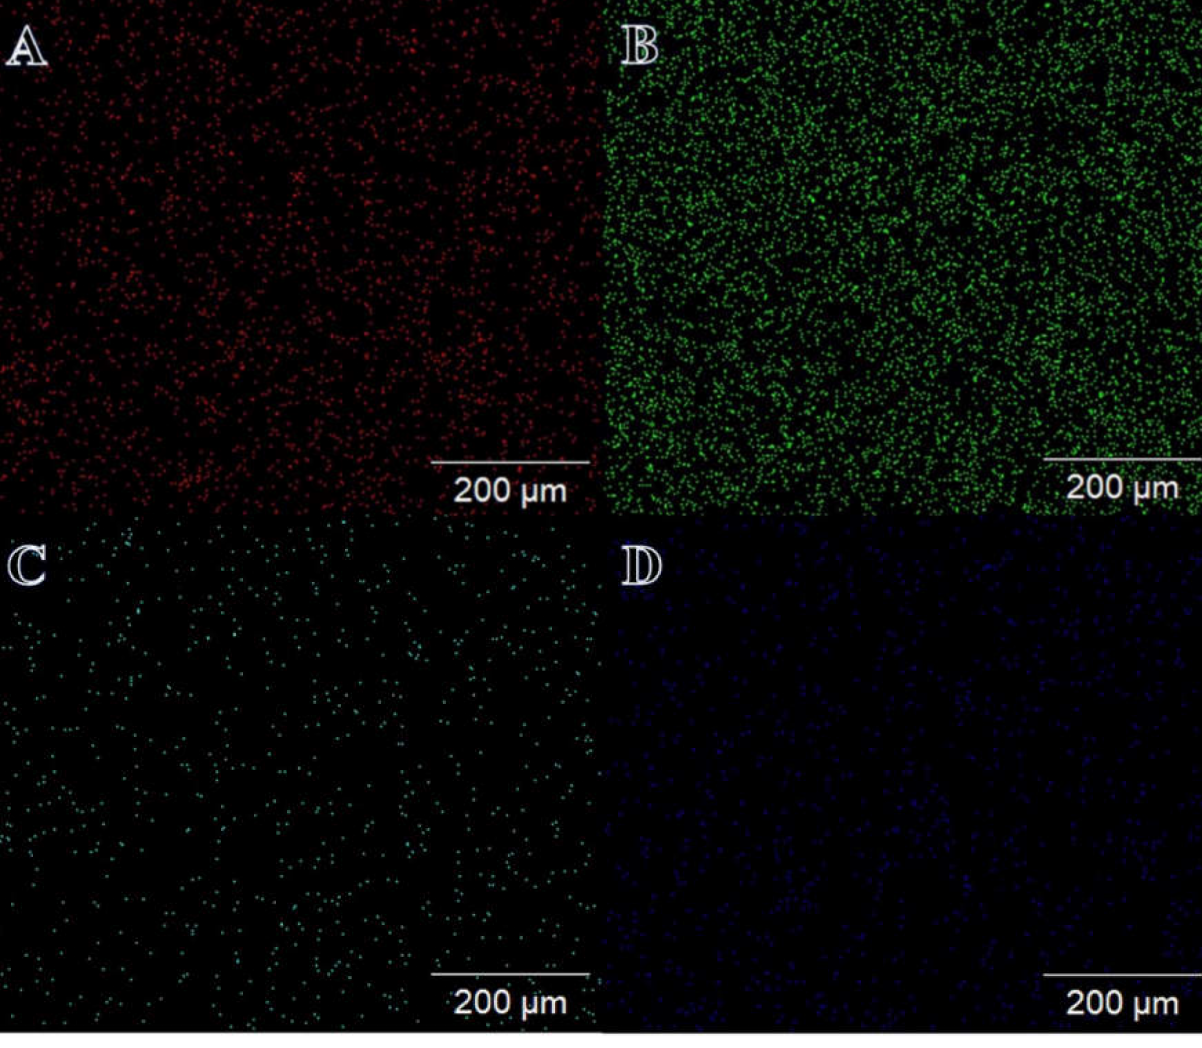
Figure 2. Elemental mapping to show the distribution of fluorine ( A ), carbon ( B ), nickel ( C ), and copper ( D ) in the Ni 0.3 Cu 0.7 /PVDF-HFP NF